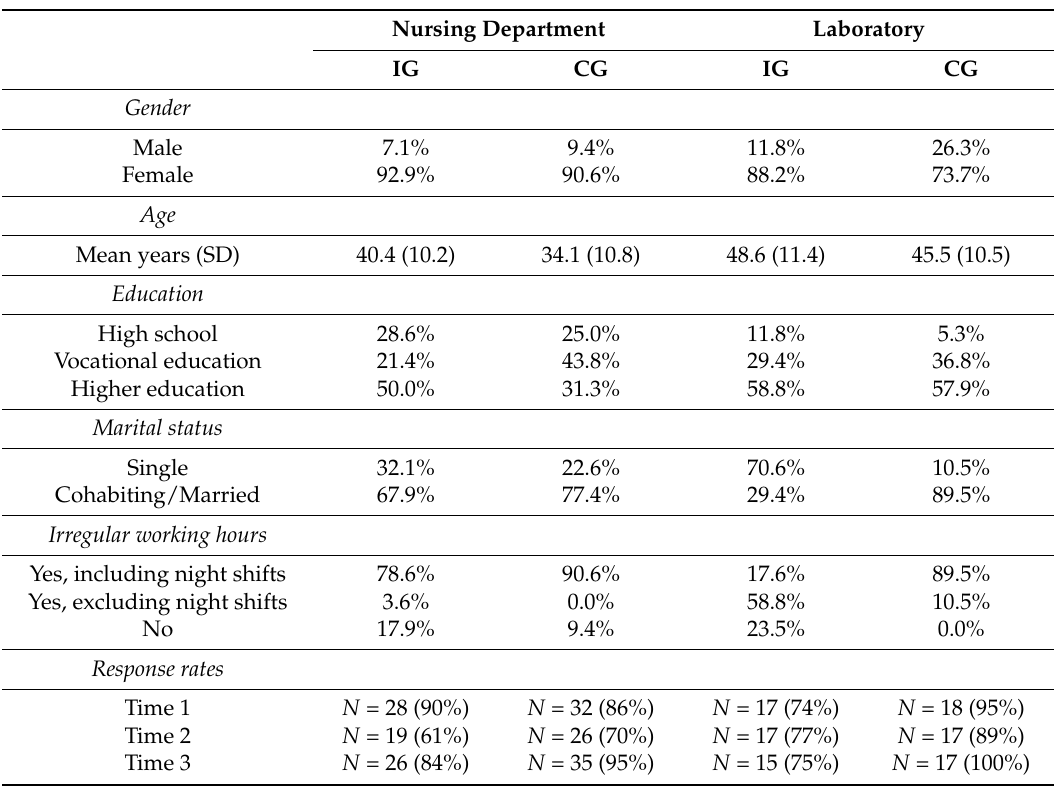
Table 1. Baseline demographic characteristics and response rates of intervention and comparison groups ( N =